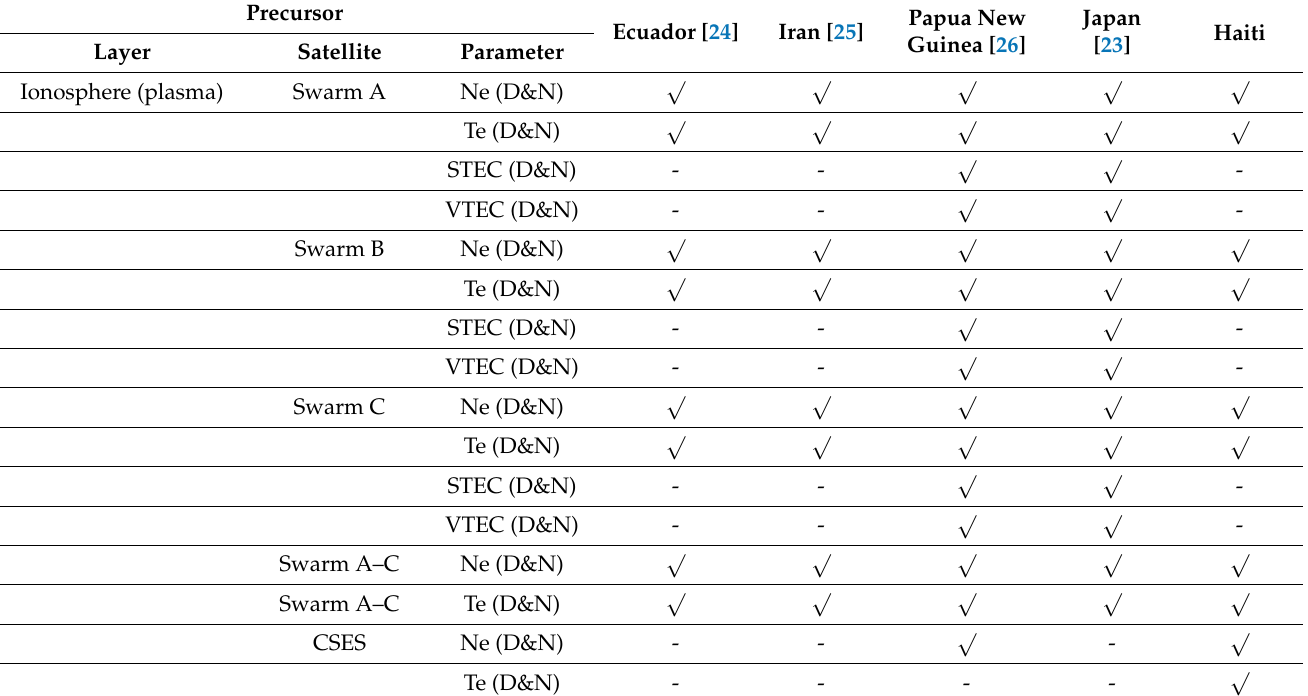
Table 2. The analysed precursors (D: day, N: night, Ne: electron density, Te: electron temperature, STEC: slant TEC, VTEC: vertical TEC, LST: Land Surface Temperature, AOD: Aerosol Optical Depth, AOT: Aerosol Optical